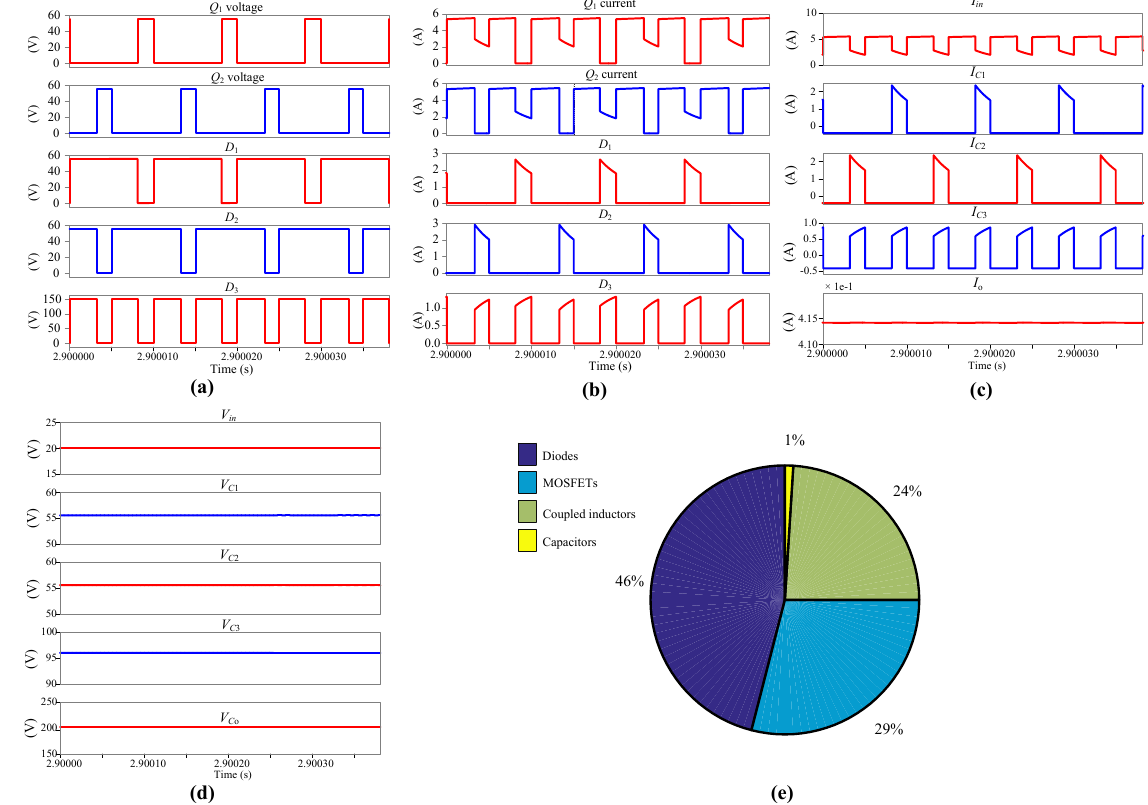
Figure 8. Simulation results of the example converter ( a ) Voltage stress across the semiconductor elements ( b ) Currents Passing through the diodes and MOSFETs ( c ) Input and output currents ( d ) the voltage of the input source, capacitors and the output ( e ) Components loss